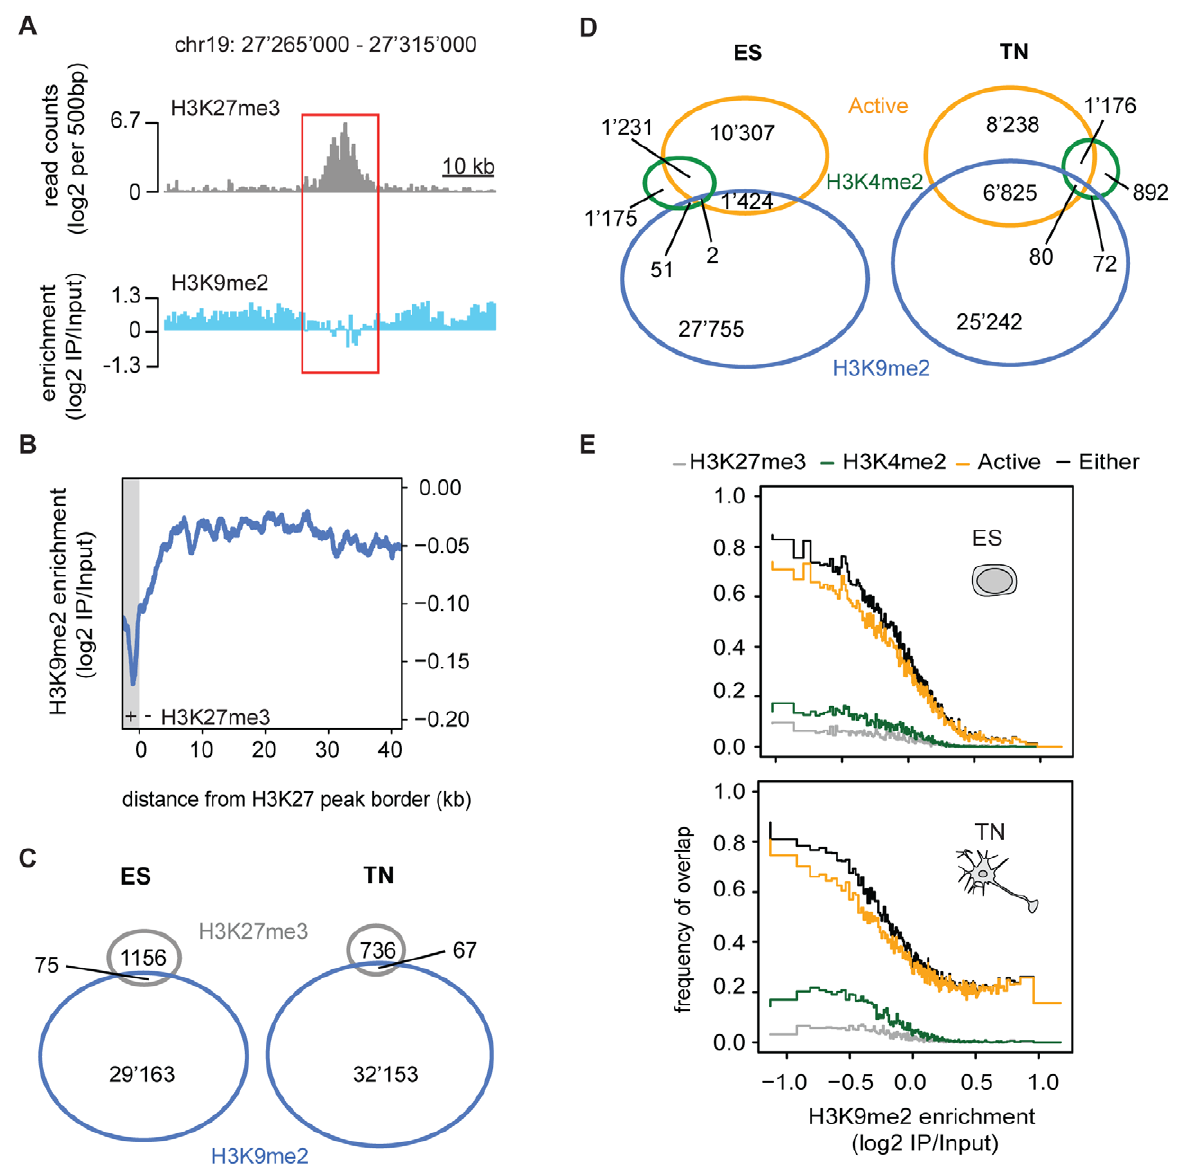
Figure 3. H3K9me2 occurs mutually exclusive with expression and distinct chromatin marks. (A) Enrichment for H3K27me3 and H3K9me2 in a representative region. (B) H3K9me2 enrichments relative to peaks of H3K27me3 illustrating the sharp boundaries between both marks. Plotted are the moving-window averages (median) of H3K9me2 enrichments with window sizes of 500 bp (blue line) around all H3K27me3 domains on chromosome 19 (shown in grey). (C) and (D) Venn diagram illustrating the actual overlap between H3K9me2 and H3K27me3 occupied regions (C) and between H3K9me2, H3K4me2 occupied and active regions (D). Numbers indicate base pair coverage on chromosome 19 (in kb). Note that areas are not drawn to scale. (E) The higher H3K9me2, the less likely a genomic region is active or contains H3K27me3 or H3K4me2. H3K9me2 enrichment values of 500 bp windows were binned into groups of equal size. Plotted is the frequency for H3K9me2 enrichment bins to overlap with active regions (orange), H3K27me3 occupied (gray), H3K4me2 occupied (green) and regions in either of these states (black).